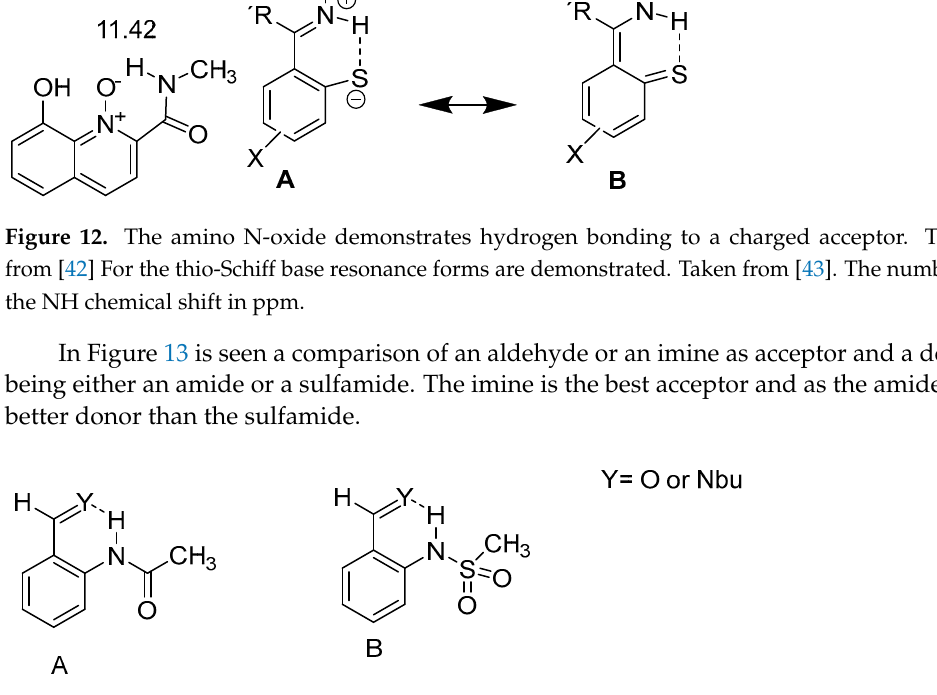
Figure 13. Comparison of different amides as acceptors. In A Y=O the NH chemical shift is 10.97 ppm, whereas when Y=N ‐ butyl it is 18.83 ppm. In B the NH chemical shift is 10.50 vs. 12.74 ppm. Taken from [46].